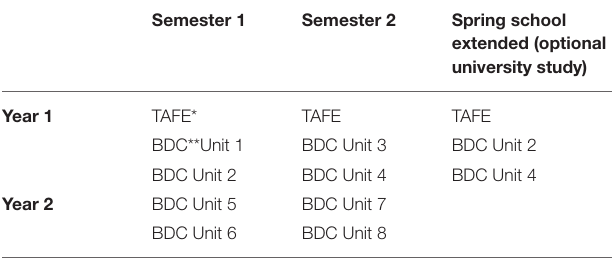
TABLE 1 | Outline of the initial 2-year plan of